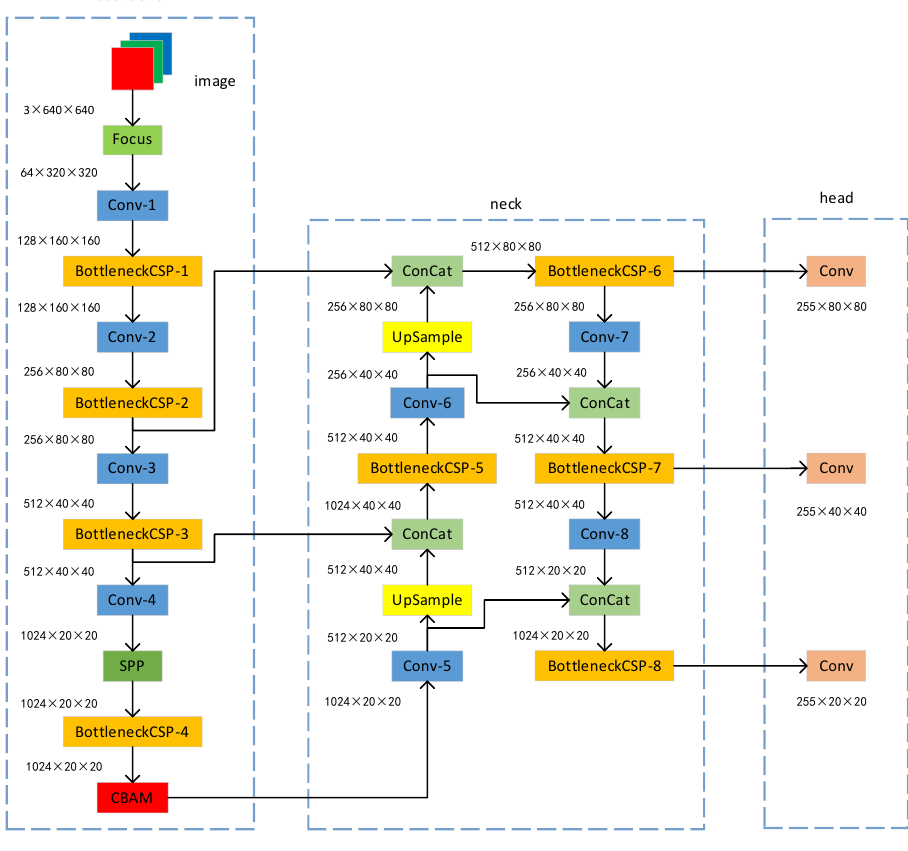
Figure 3. Structure of the CBAM-YOLOv5s network.